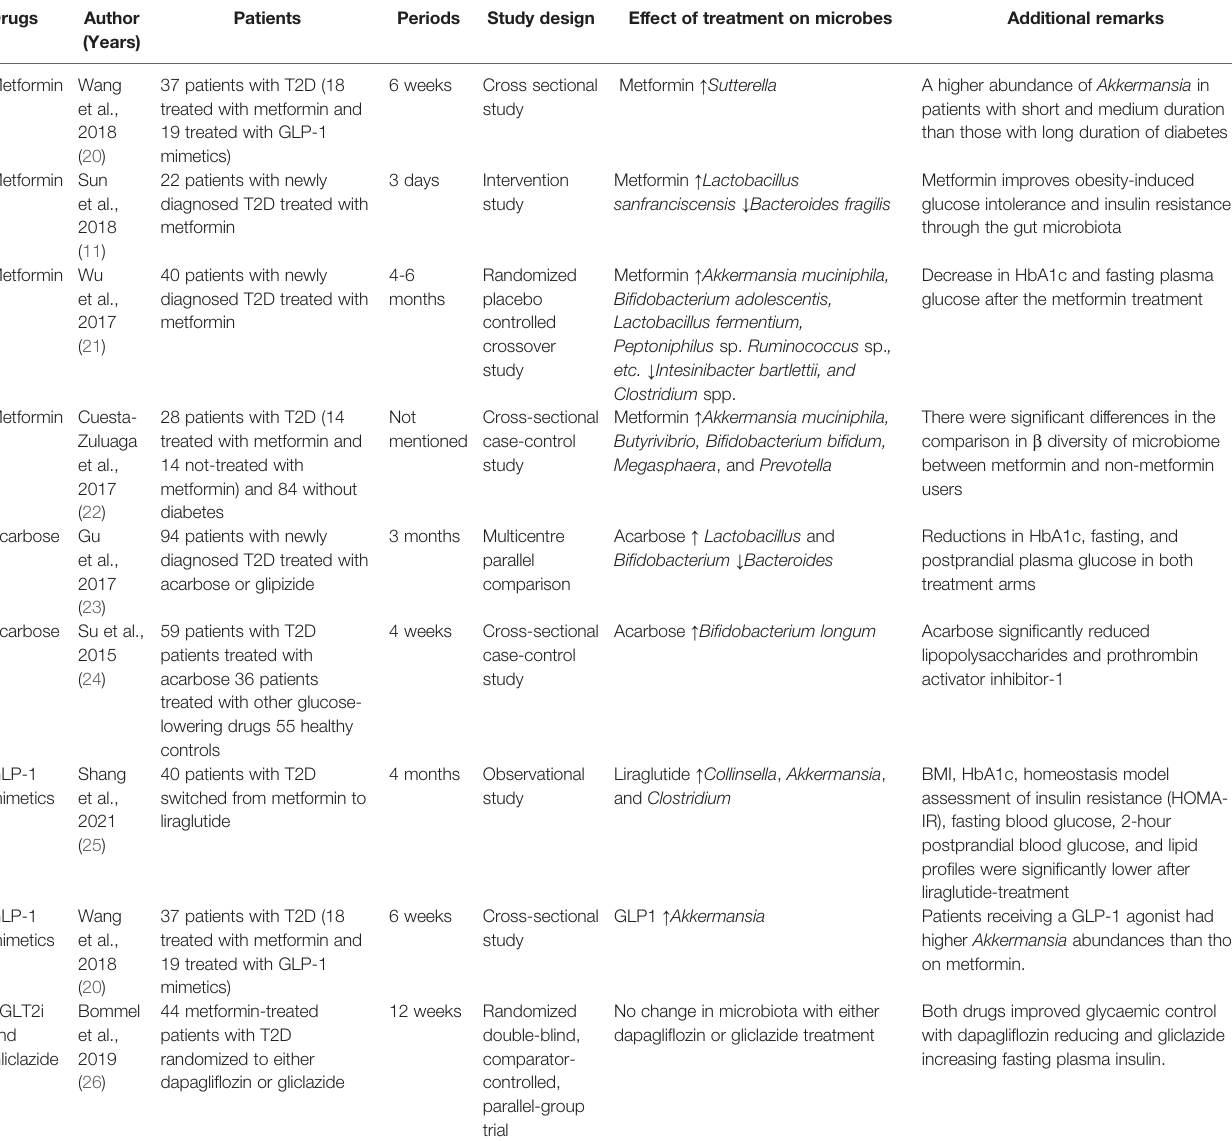
TABLE 1 | Summary of the effects of western medicine on the composition of the gut microbiome in T2D patients.